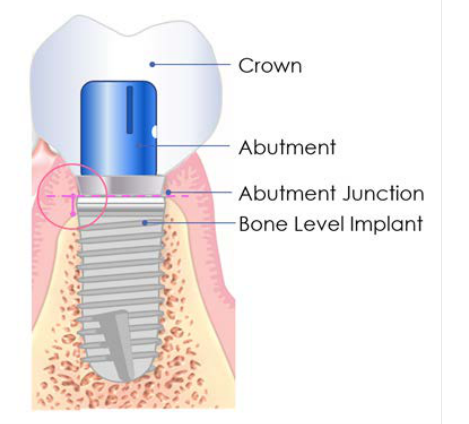
Table 1. Characteristics of the study